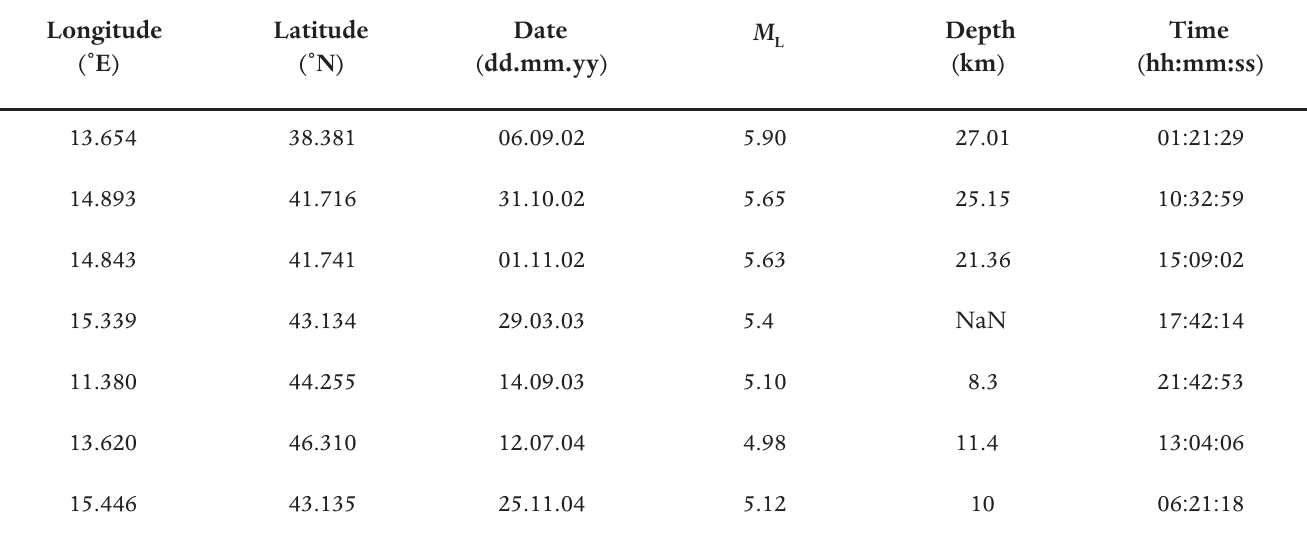
Table 1. List of observed earthquakes in the target period (2002-2006) recorded in the CPTI08 catalog